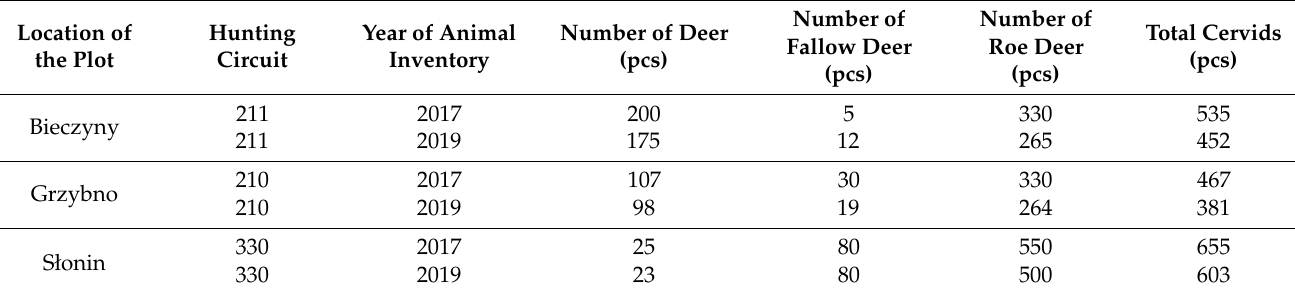
Table 5. The number of individuals of deer animals found because of inventory in the spring of 2017 and 2019 in hunting districts where the browse plots were established.